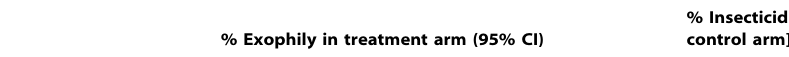
Table 4. Exophily and insecticide-induced exiting of free flying Anopheline